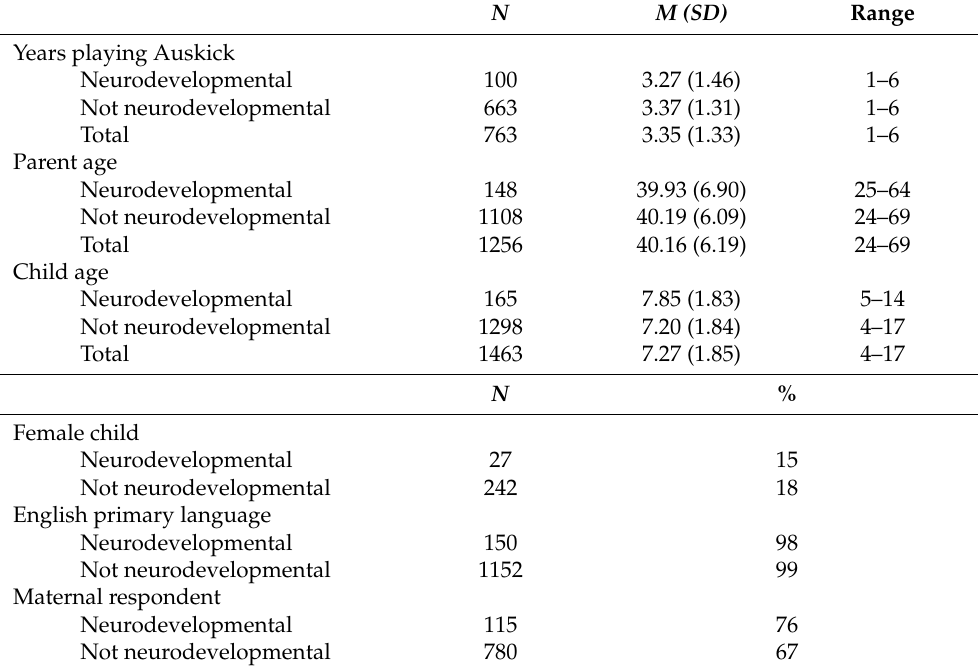
Table 1. Participant characteristics.